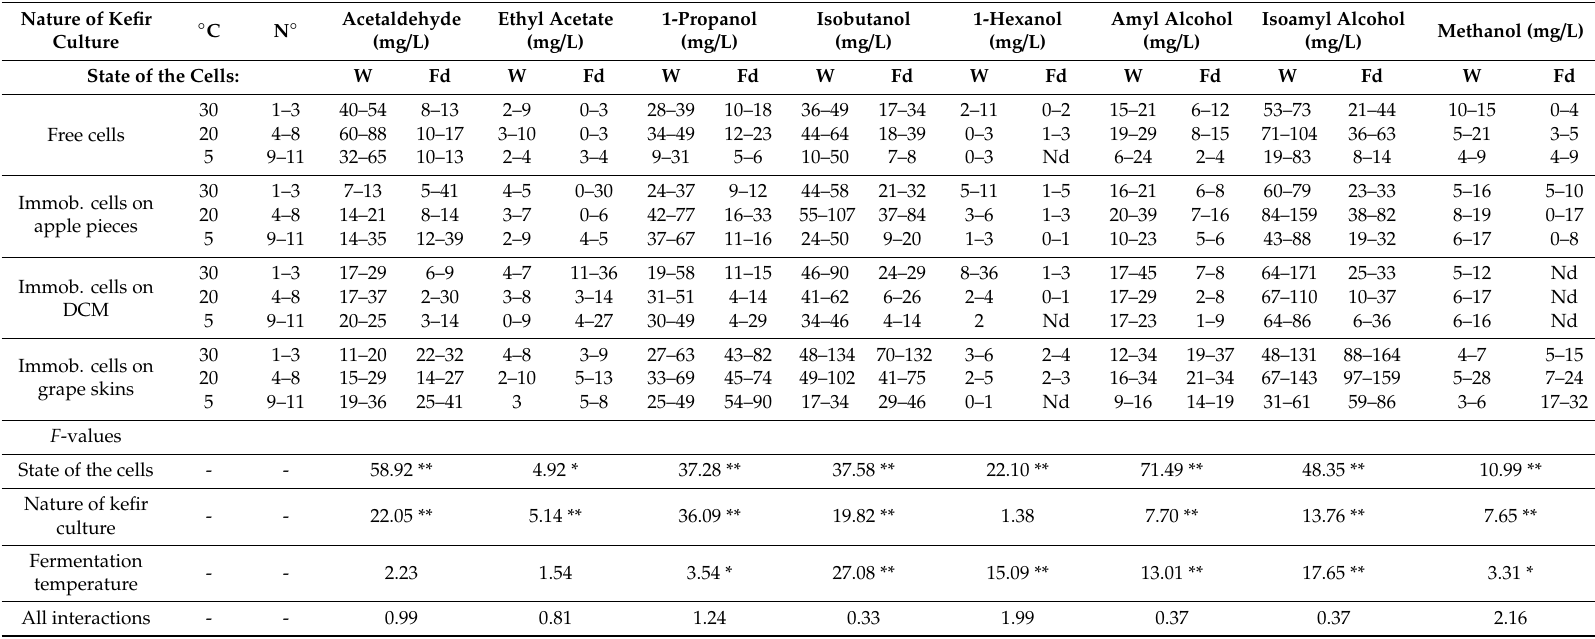
Table 4. Major volatiles of low alcohol wines produced by repeated batch fermentations at 5–30 ◦ C using wet or freeze-dried kefir culture. Nature of Kefir